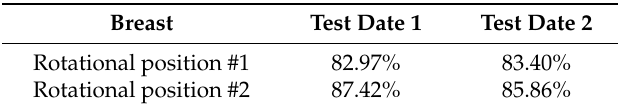
Table 3. Confidence Level for Breast